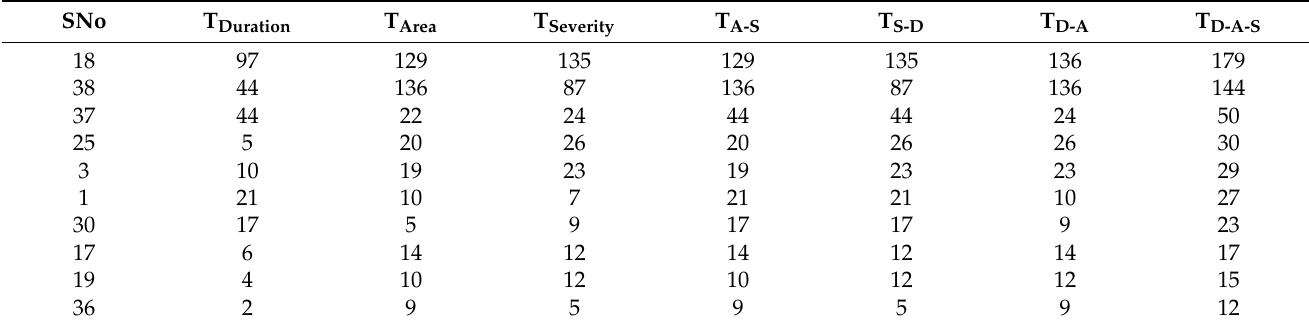
Table 4. The return period of the ten strongest historical soil droughts (unit: